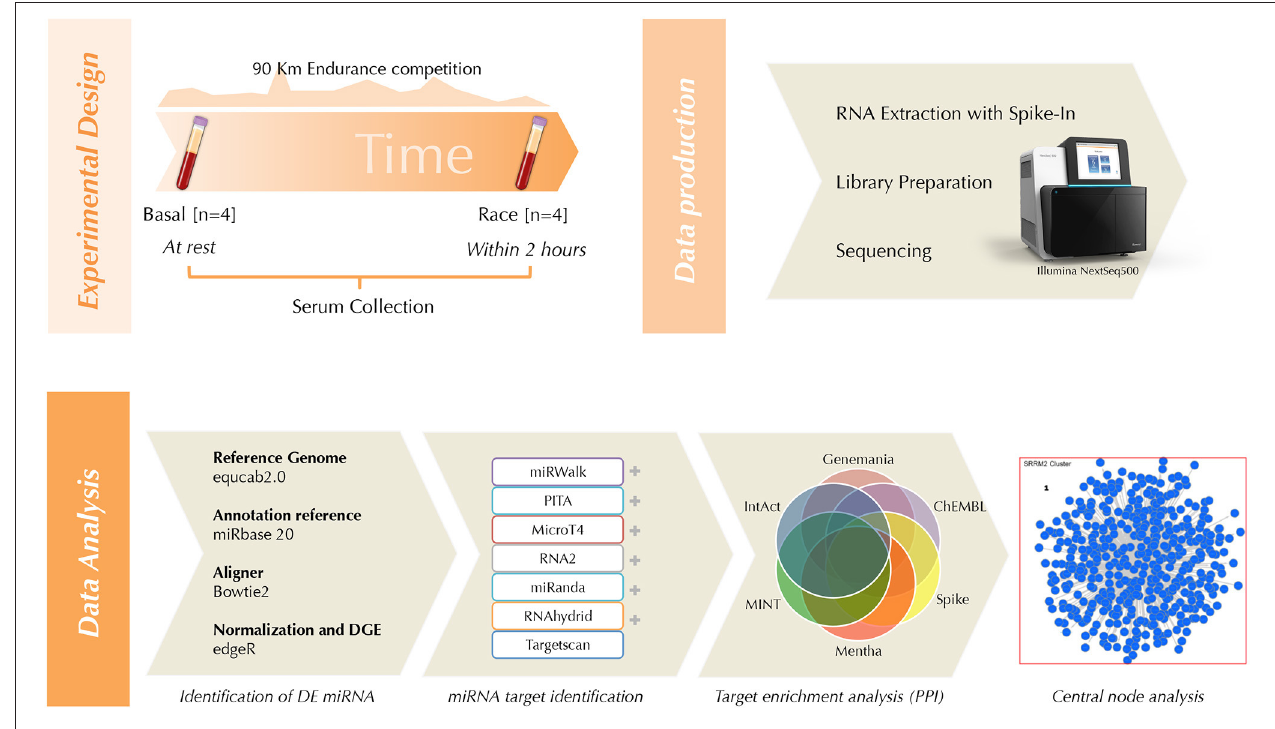
FIGURE 2 | Workflow